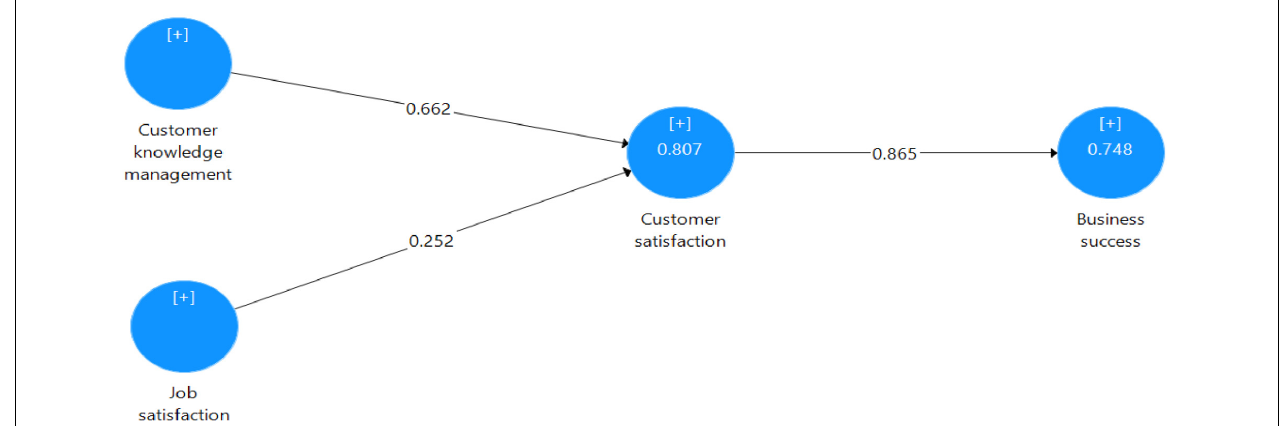
FIGURE 2 | Results of the coefficient of variance R 2 . Source, Author’s